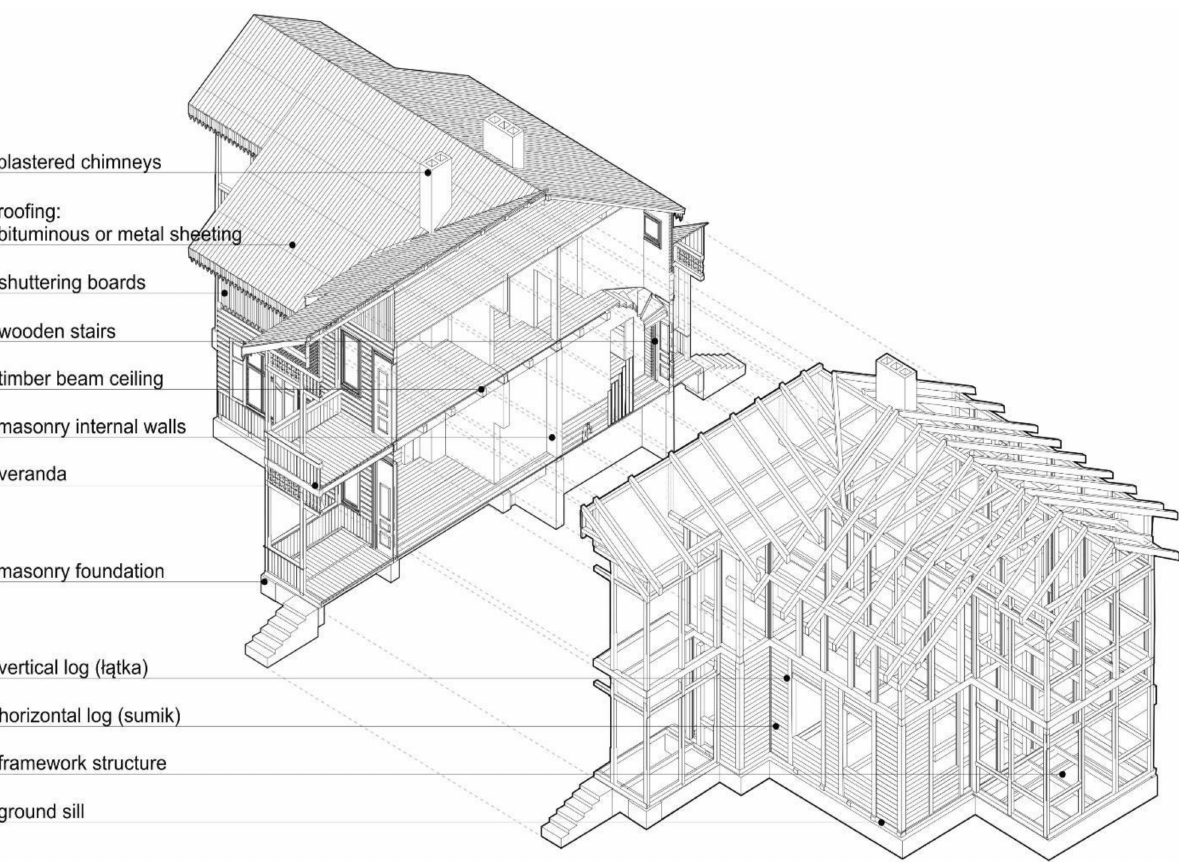
Figure 7. Typical wooden structure layout of a ´ Swidermajer-type building, by M. G ó rski and D.